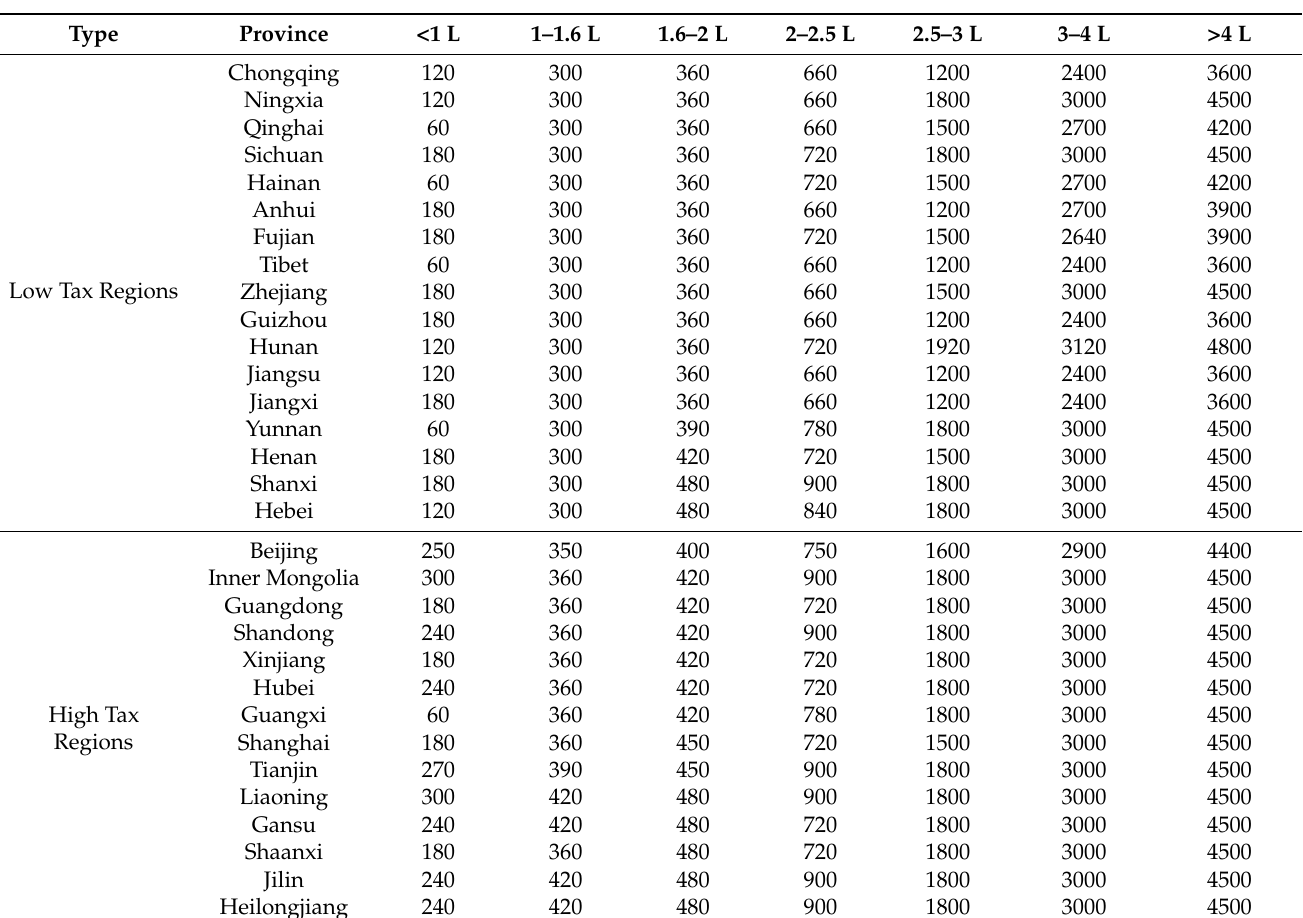
Table A1. The indicators of VVT in 31 provincial administra-tive regions (yuan/year) and the preferential policies about VVT in mainland